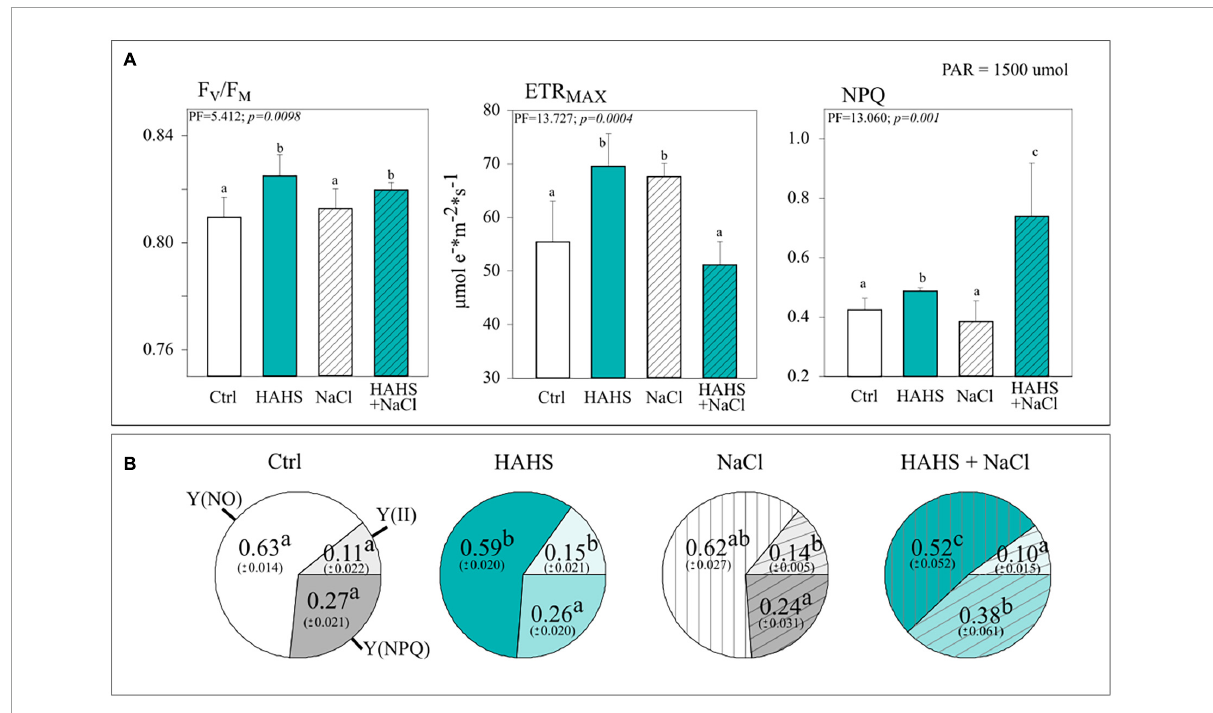
FIGURE5 Salinispora arenicola enhances quantum yield and photoprotection under saline stress. (A) Photosynthethic performance parameters and (B) Yield coefficients of the absorbed energy distribution. Parameters were measured with a non-intrusive pulse-amplitude modulated (PAM) device ( n = 6) 39 days after germination (DAG) in plants grown with either NaCl-free or saline irrigation and inoculated with a habitat-adapted heterologous symbiont (HAHS) bacteria (turquoise bars) or not (control; C, white bars). F V /F M , Maximum photochemical quantum yield of PSII; ETR MAX , Maximum electron transfer rate; NPQ, Stern-Volmer type non-photochemical fluorescence quenching; Y(NO), Quantum yield of non-regulated heat dissipation and fluorescence emission; Y(II), Effective photochemical quantum yield of PSII; Y(NPQ), Quantum yield of light-induced non-photochemical fluorescence quenching. Statistical significance was determined separately for each irrigation scheme using a univariate analysis of variance (ANOVA; p = 0.001). Lowercase letters denote statistical differences (pairwise test) among